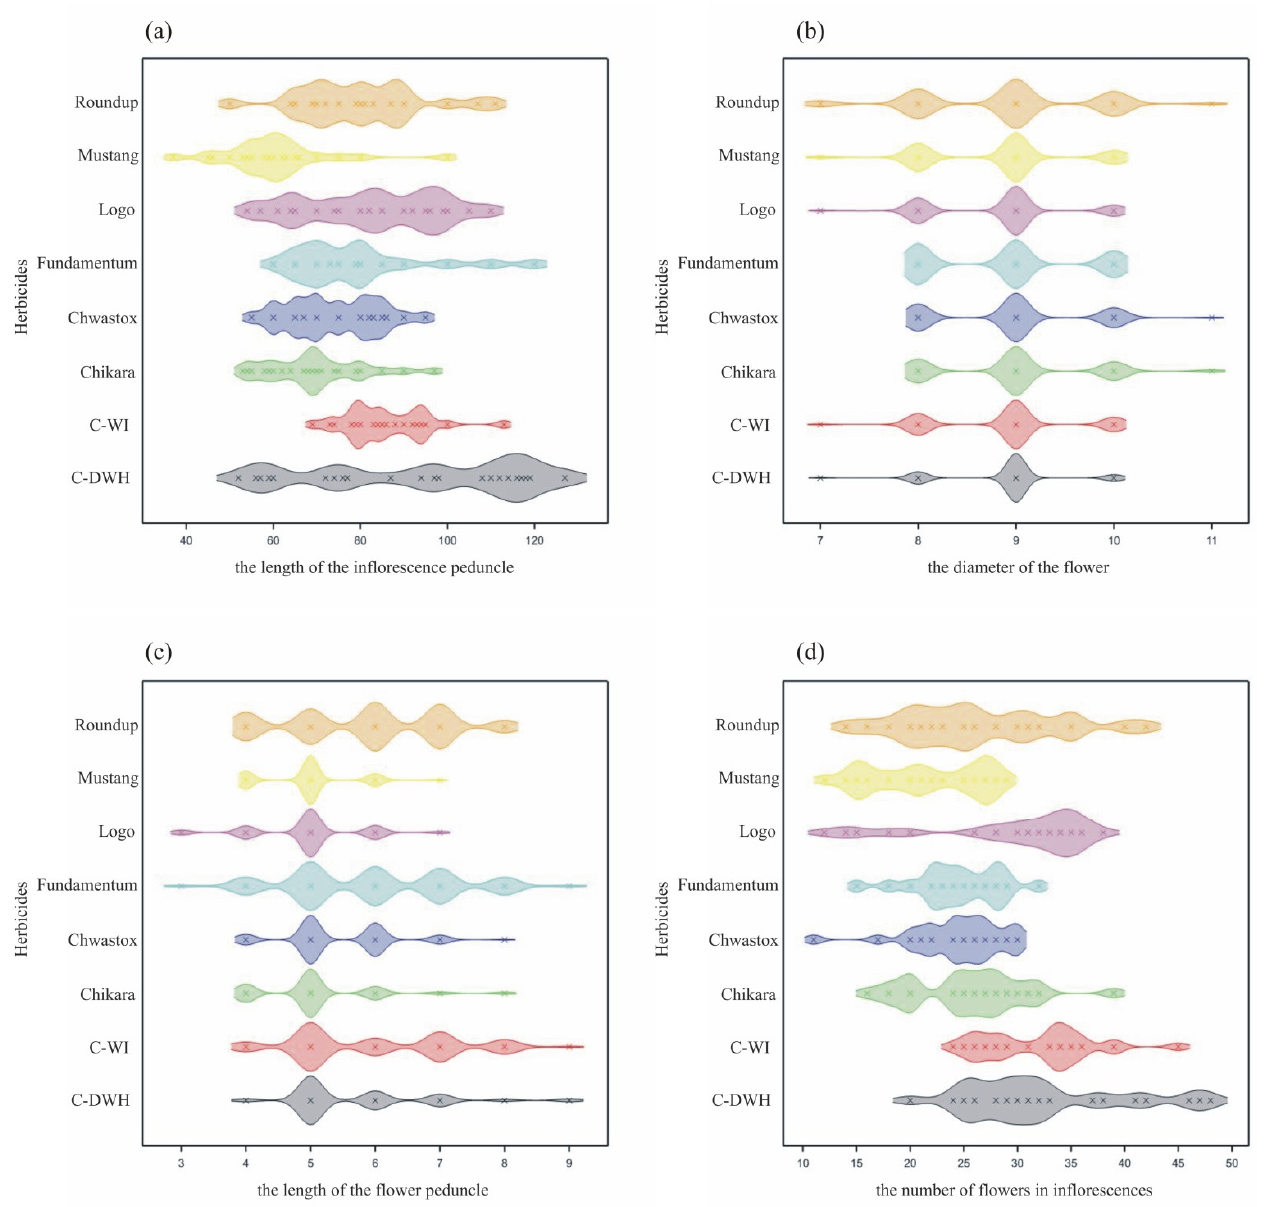
Figure 1. The density plot of inflorescence and flowers features by herbicides ( a ) length of inflo- rescence peduncle, ( b ) flower diameter, ( c ) length of flower peduncle, ( d ) number of